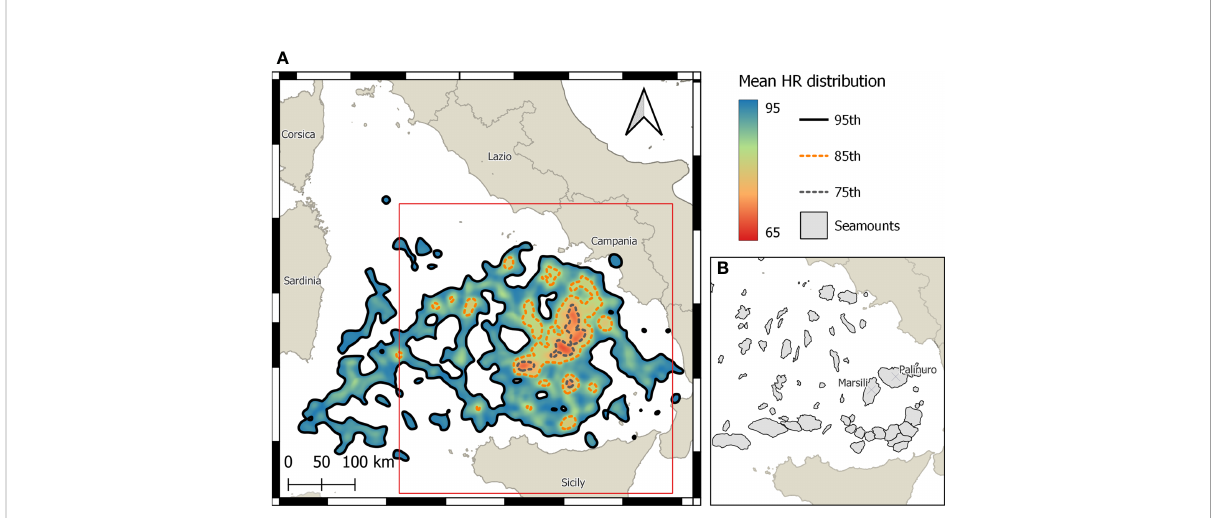
FIGURE 2 (A) Average home range distribution of 16 loggerhead turtles during the whole period of tracking (4,979 observations) and (B) location of major seamounts in the Tyrrhenian Sea (right panel referring to the area con fi ned by the red rectangular in the left panel).